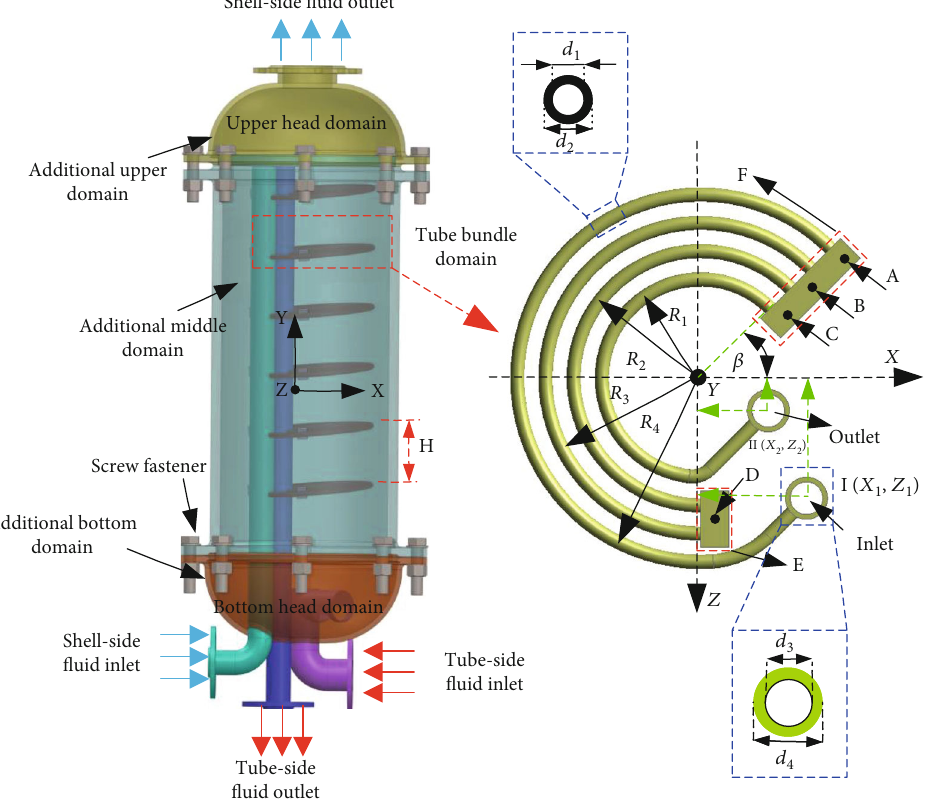
Figure 1: Schematic diagram of the elastic tube bundle heat exchanger [1]. Table 1: The structure and value of planar elastic tube bundles in the present